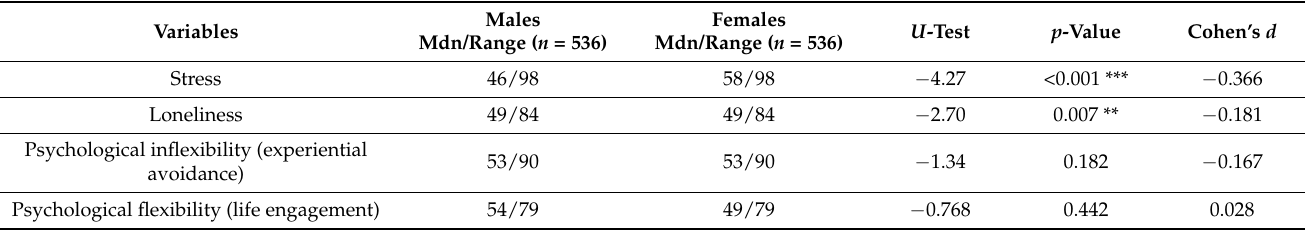
Table 2. Gender differences in outcome variables.